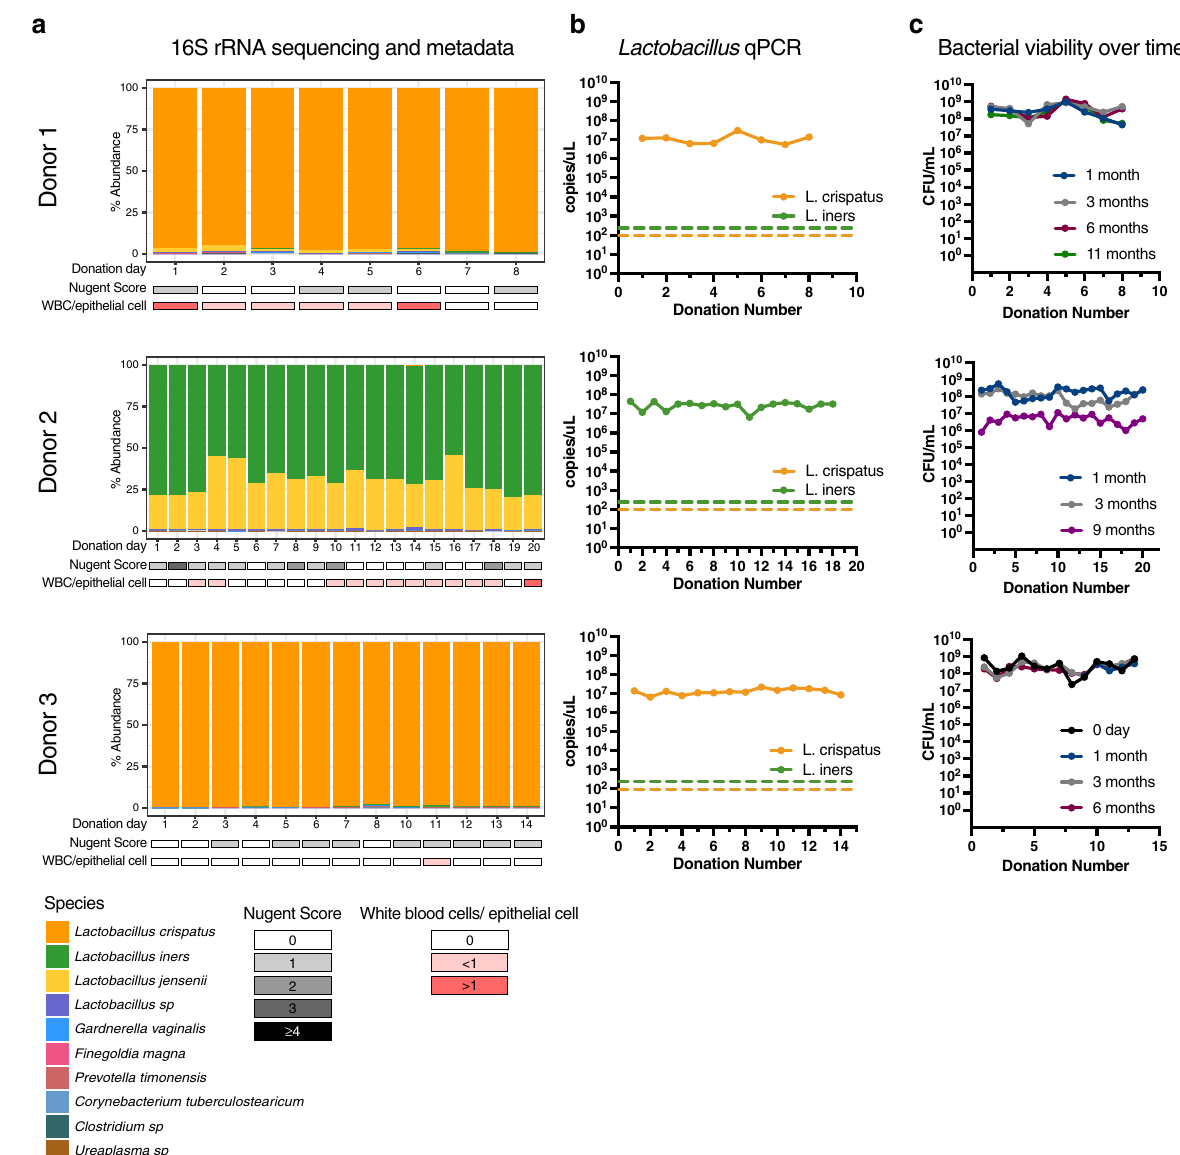
Figure 3. Microbial community profiles of VMT donation samples. ( a ) Microbial community and metadata. Relative abundance of the bacterial community in the donation material was determined using 16S rRNA amplicon sequencing for each donation. Nugent score and white blood cell (WBC)/epithelial cell ratio are presented below each donation. ( b ) Absolute quantification of L. crispatus and L. iners in donation samples using species-specific qPCR. Detection limit of the assay is depicted by dashed lines. ( c ) Donation stability measured as Lactobacillus CFUs streaked and counted on MRS agar at long-term intervals post Lactobacillus viability after untreated storage at − 80 °C.